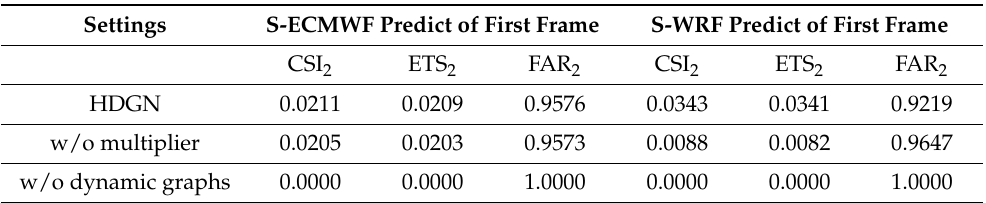
Table 9. Influence of the configuration of each dynamic building block on the forecasting results of the HDGN